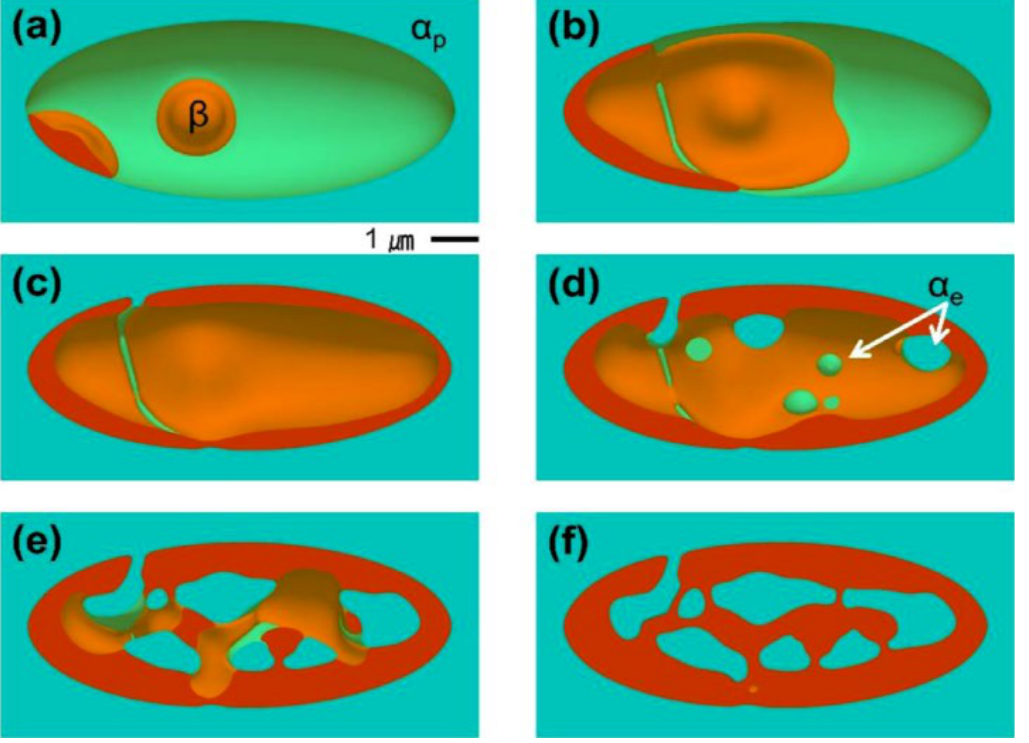
and phase nucleated and grew in the interdendritic melt. Figure 12. The eutectic Figure 12. The eutectic α and β phase nucleated and grew in the interdendritic melt. α p : primary α phase, : eutectic phase. : eutectic phase: ( a – c ): phase nucleates randomly in the liq- phase, α e : eutectic α phase. β : eutectic β phase: ( a – c ): β phase nucleates randomly in the liquid but α β uid but preferentially grows along the perimeter of the -liquid interface and cover it entirely, ( d – preferentially grows along the perimeter of the α -liquid interface and cover it entirely, ( d – f ): eutectic α α e α β β β phase nucleation and growth until complete solidification [101]. f ): eutectic α phase nucleation and growth until complete solidification α α